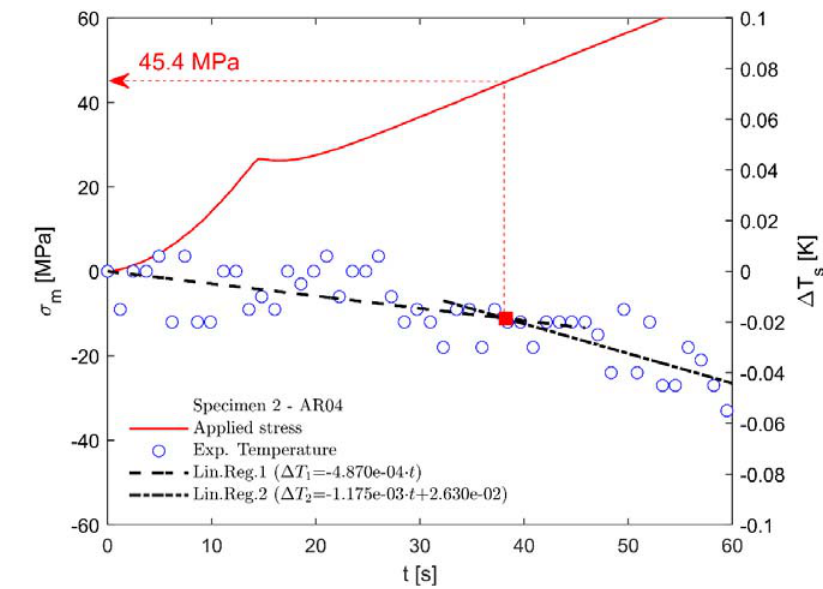
Figure 8:  T vs time curve (blue points) and stress vs time curve (red line) for area AR04 of Specimen 2. .